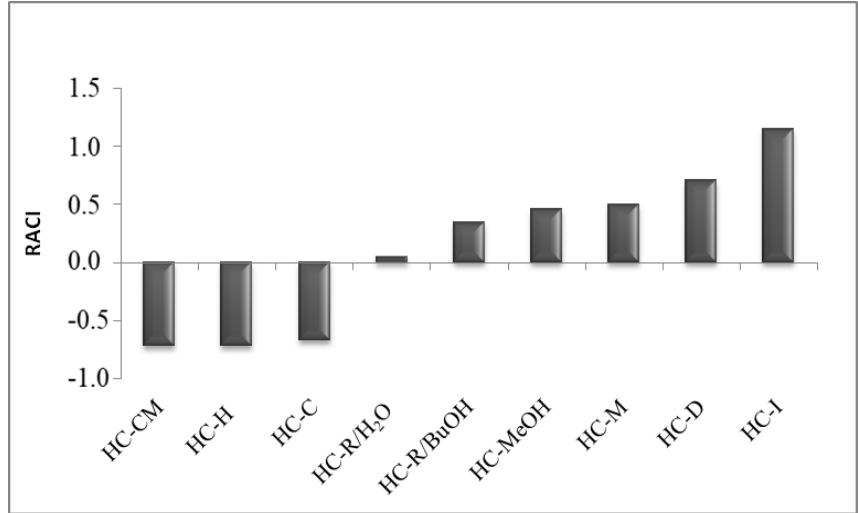
Figure 1. RACI (relative antioxidant capacity index) values obtained by comparing TPC, DPPH, FRAP, BCB, NO, and SO results. TPC: total polyphenolic content; DPPH: